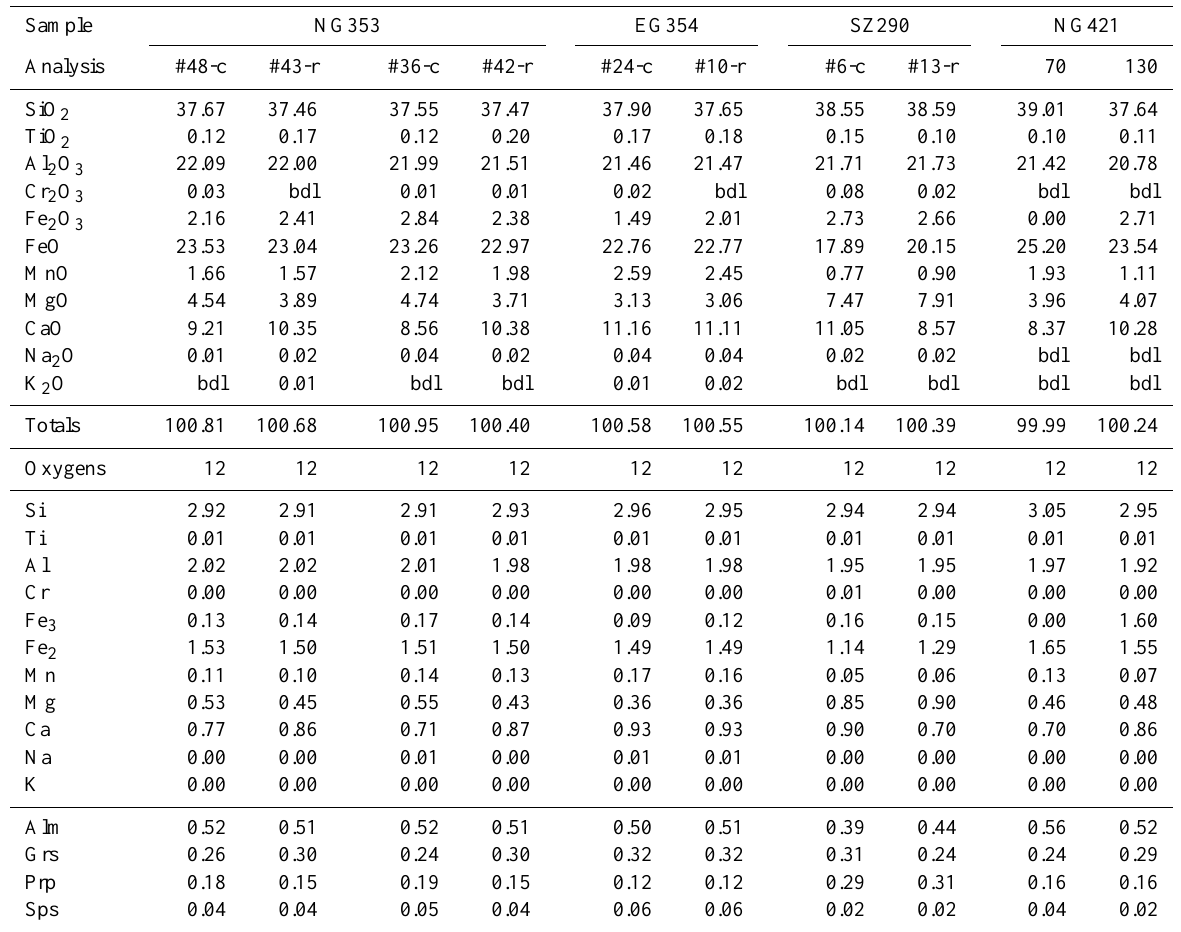
Table 4a. Representative EMPA analyses of